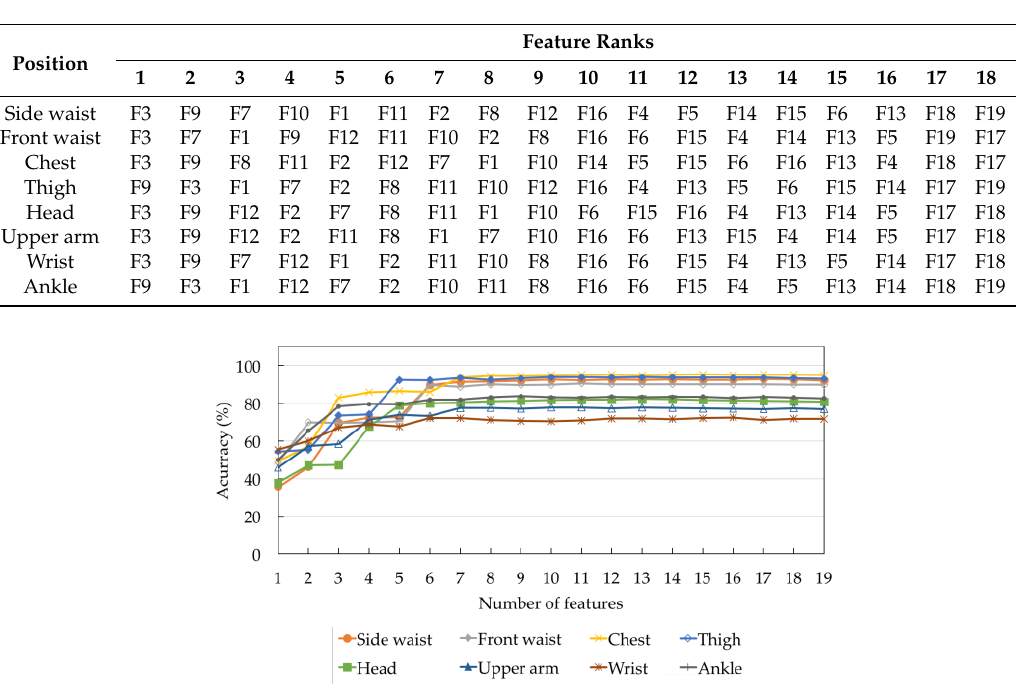
Figure 6. The average accuracy of the eight classification models across all sensor positions on DS1.